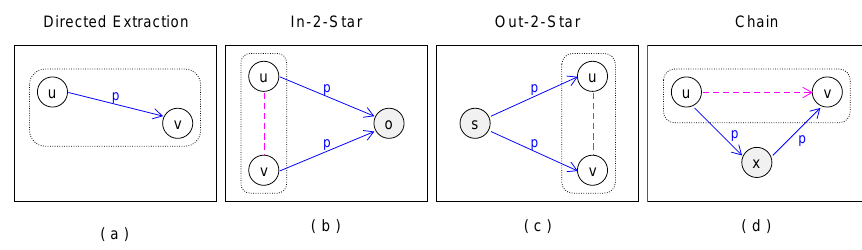
Figure 3. Extraction patterns with one predicate. ( a ) Direct Extraction: one direct connection from u to v . ( b ) In-2-Star: two connections are coming-into o from u and v . ( c ) Out-2-Star: two connections are going-out s to u and v . ( d ) Chain: two successive connections between u and v via x